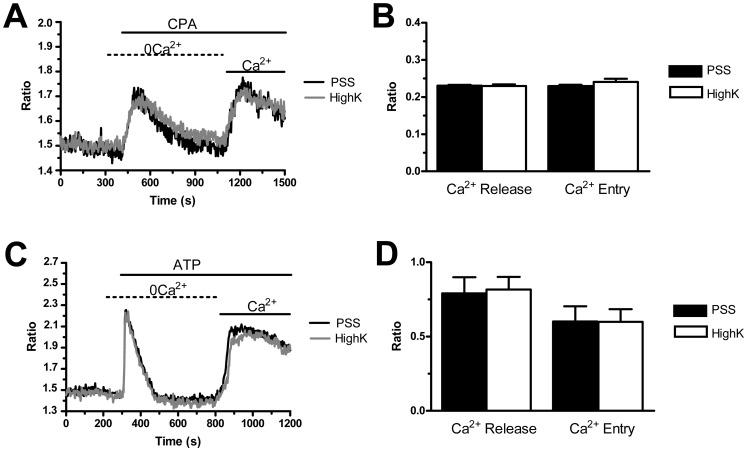
The amplitude of store-operated Ca2+ entry is not reduced by a high-K+ extracellular solution in endothelial colony forming cells isolated from patients affected by primary myelofibrosis.100 mM NaCl in the extracellular solution was replaced with an equimolar amount of K+ (HighK) to clamp the membrane potential at 0 mV and observe the consequences on the extent of SOCE activation in PMF-ECFCs. A, HighK did not affect either the amplitude or the kinetics of CPA (10 µM)-induced Ca2+ signals in PMF-ECFCs. Black and grey tracings illustrate CPA-dependent Ca2+ signals in the absence and presence of HighK, respectively. B, mean±SE of the amplitude of CPA-induced Ca2+ release and CPA-induced SOCE in the absence (black bar; n = 76) and in the presence of HighK (white bar; n = 77). C, the biphasic Ca2+ response to ATP (100 µM) was not impaired by HighK. Black and grey tracings illustrate ATP-dependent Ca2+ signals in the absence and presence of HighK, respectively. D, mean±SE of the amplitude of ATP-elicited Ca2+ release and ATP-elicited SOCE in the absence (black bar; n = 88) and in the presence of HighK (white bar; n = 95). In panels A and C, each trace is representative of at least three independent experiments conducted on cells isolated from three distinct healthy donors and three PMF patients.